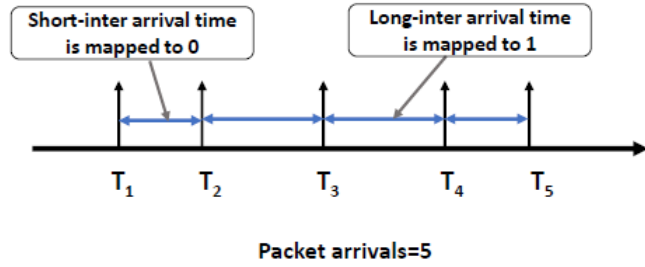
Figure 2. Representation of binary symbols in the packet inter-arrival